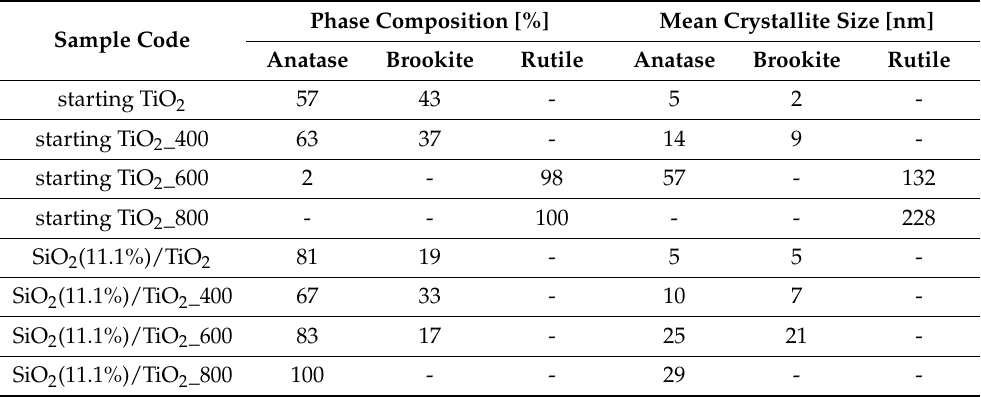
Figure 1. XRD patterns of starting TiO 2 and reference materials ( A ) and fumed silica-modified TiO 2 prior and after heat treatment ( B ). Table 1. XRD phase composition and crystallite size.